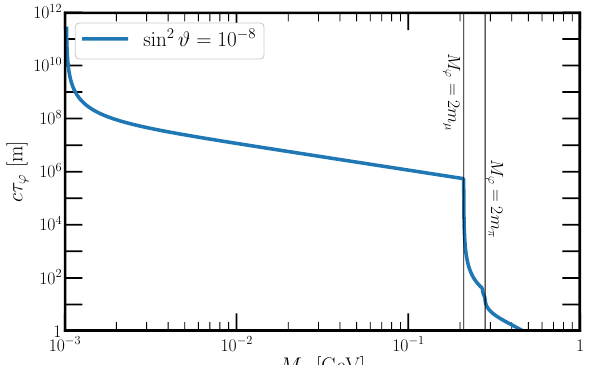
Figure 16 . Rest-frame lifetime of a dark Higgs with mixing sin 2 # = 10 (cid:0) 8 as a function of mass M ’ . We label the points at which the decays ’ accessible for